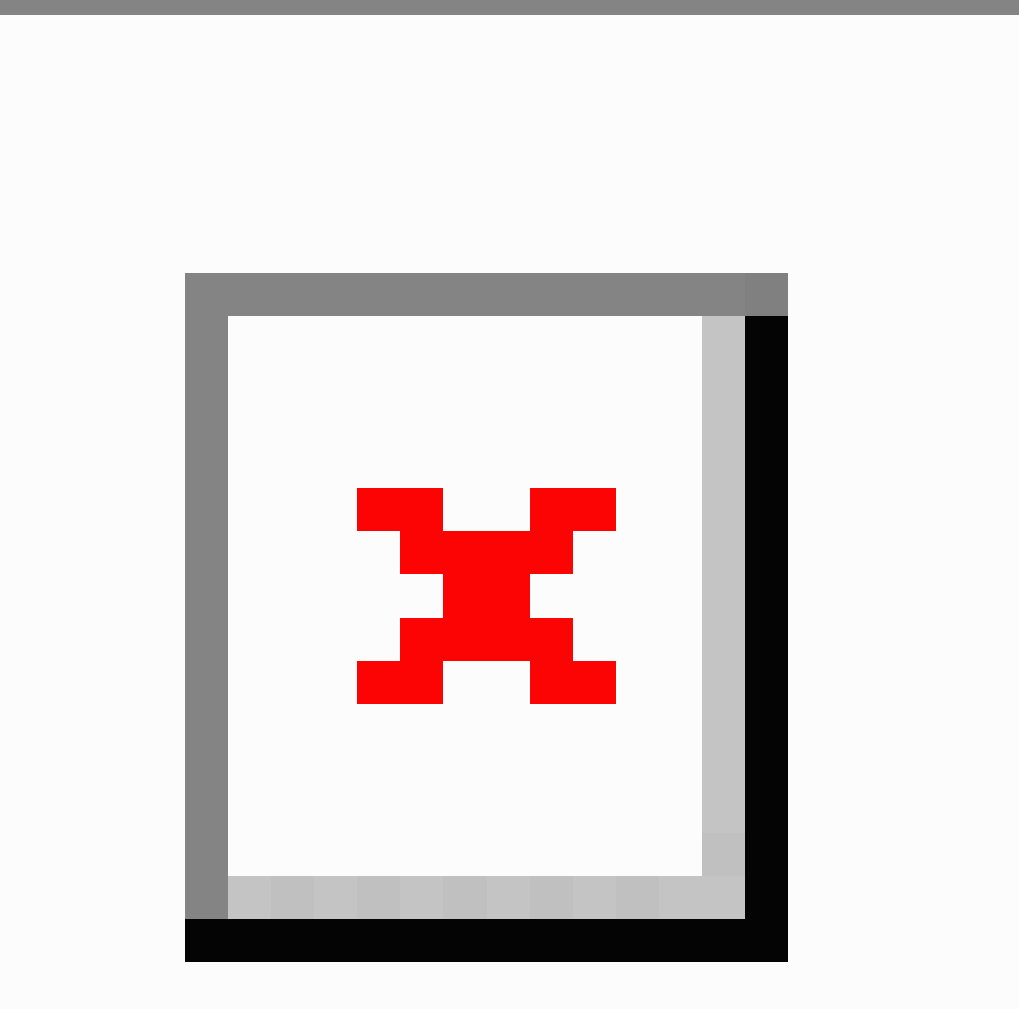
Figure 1. Timeline illustrating vital signs data extraction window from the time of ICU admission. ICU: intensive care